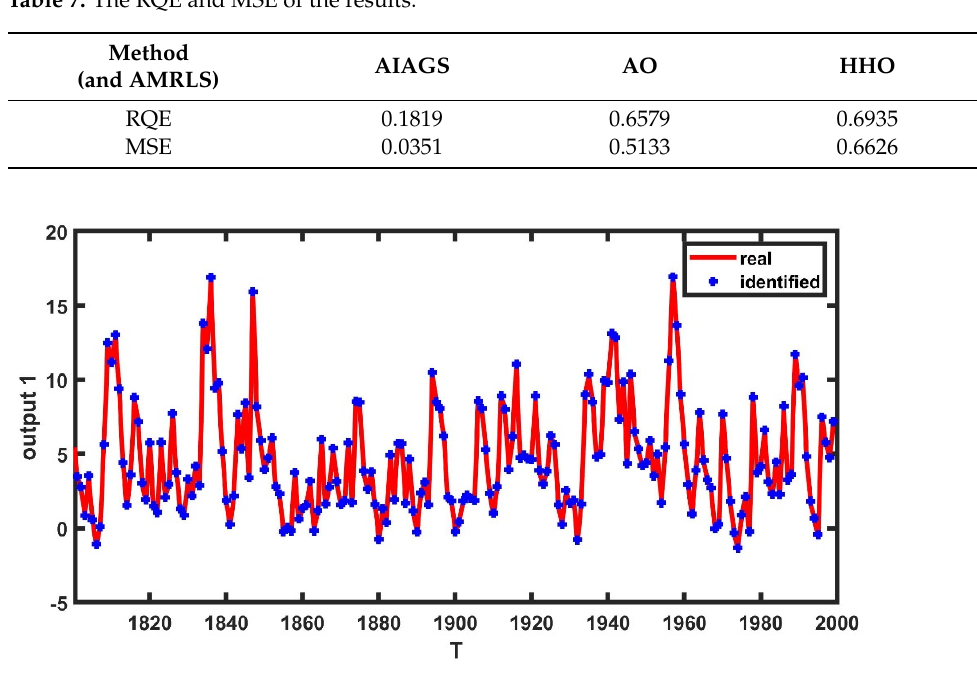
Figure 9. The real output 1 and the identified output 1.